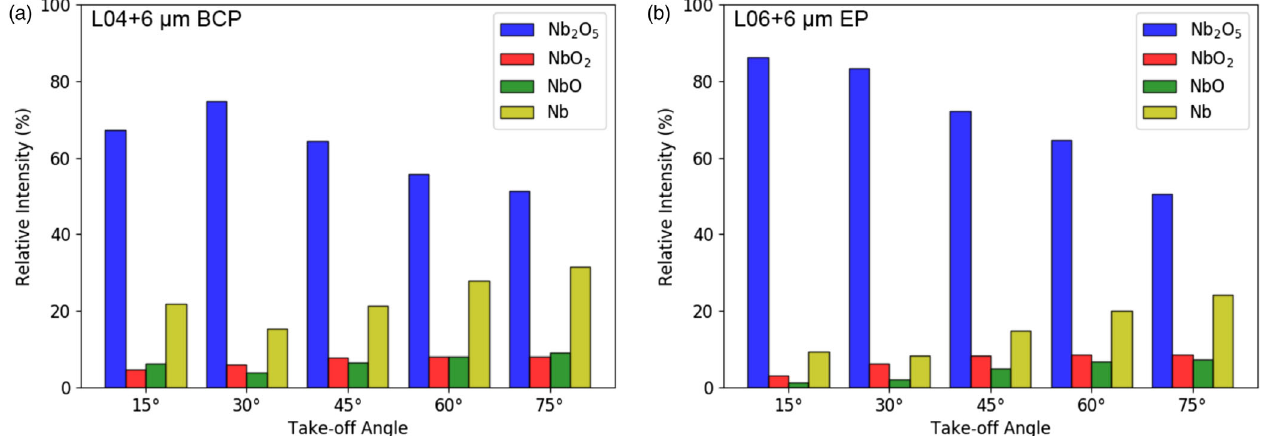
FIG. 7. Relative intensity variation of different Nb phases on the N-doped Nb surface after 6 μ m surface removal with (a) BCP and (b) EP relative to different XPS takeoff angles.